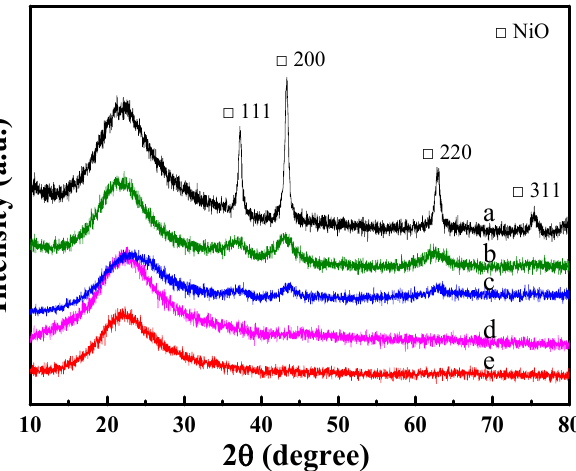
Figure 1. X-ray diffraction patterns of the as-prepared Ni/SiO 2 ( a ), Ni-G-2/SiO 2 -C ( b ), Ni-G-1/SiO 2 - P ( c ), Ni-G-2/SiO 2 -P ( d ), and Ni-G-3/SiO 2 -P ( e ) catalysts.